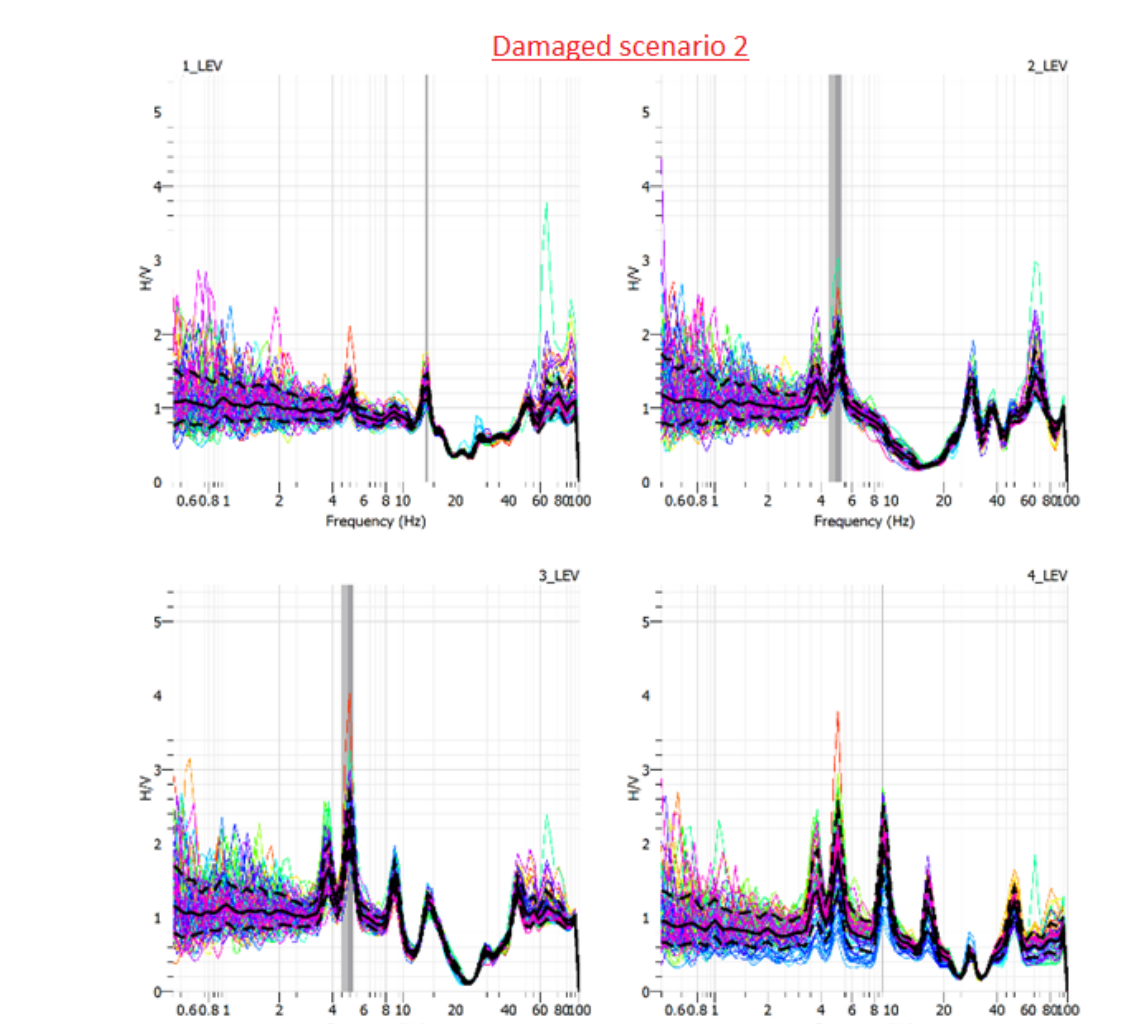
Figure 29. HVSR analysis of ambient noise recording for damaged scenario 2 of the metallic